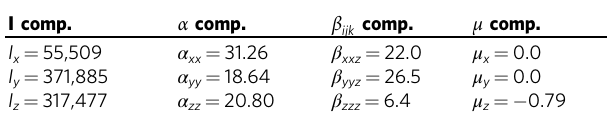
Table 1 Summary of the SO 2